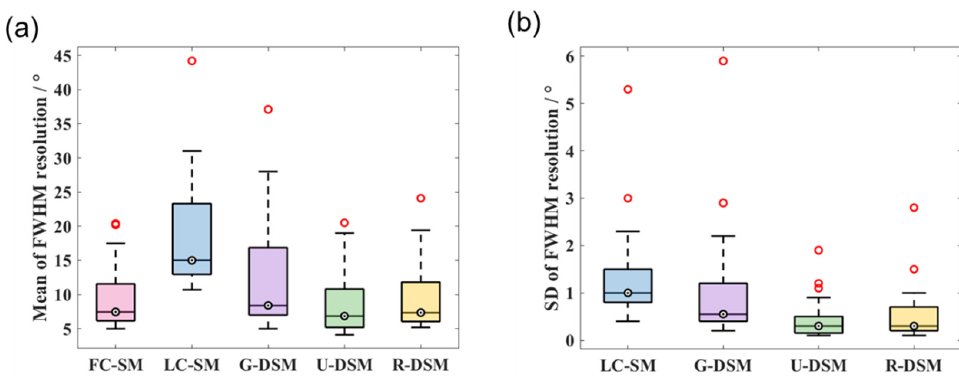
Figure 22. Box plots of ( a ) mean values and ( b ) SD values of FWHM resolution at 36 different source positions for 99m Tc source in inter-device evaluation.